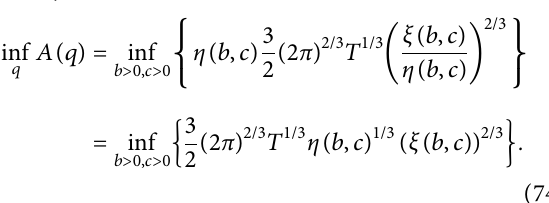
Figure 9: The progressive evolution of a Poincar´e surface of sections for different energy levels in the unequal masses case ( m m � 0 . 31, m � m � 1, b � 1 . 1, and c � 0 . 2 3 1